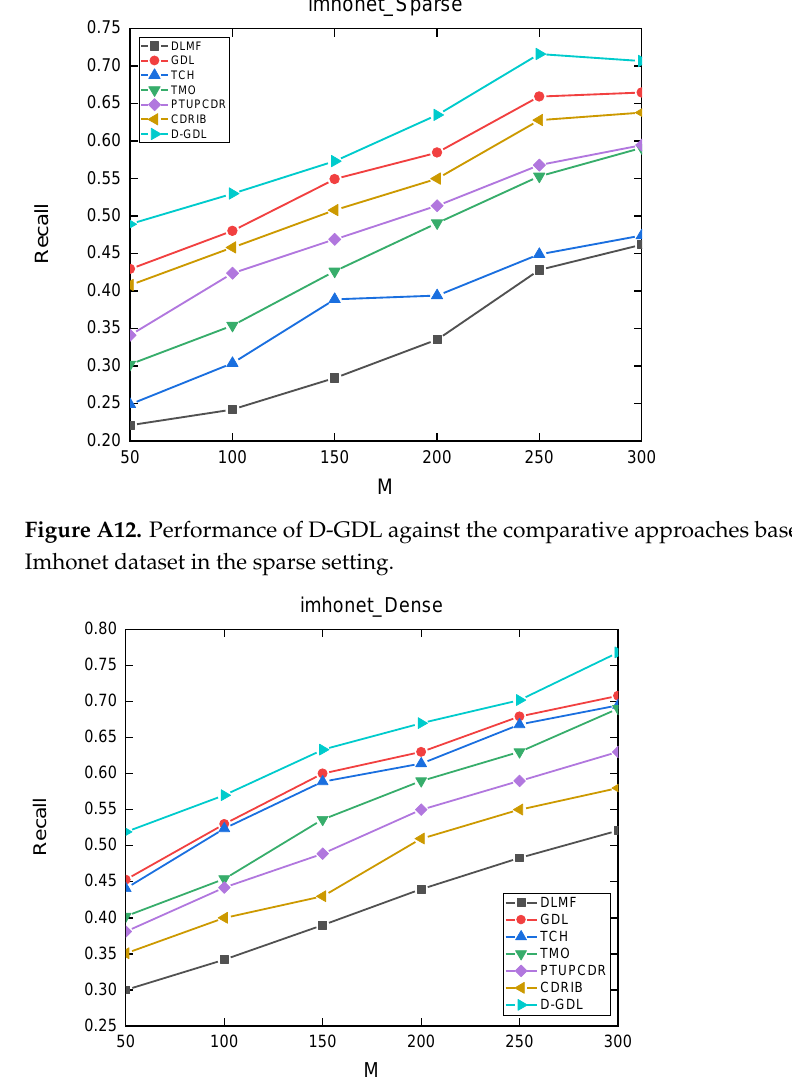
Figure A13. Performance of D-GDL against the comparative approaches based on Recall vs. M for Imhonet dataset in the dense setting.